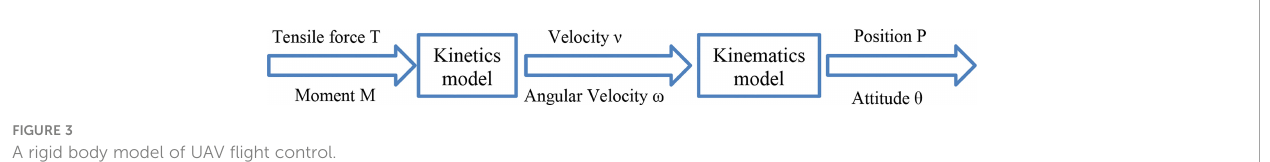
FIGURE 3 A rigid body model of UAV fl ight